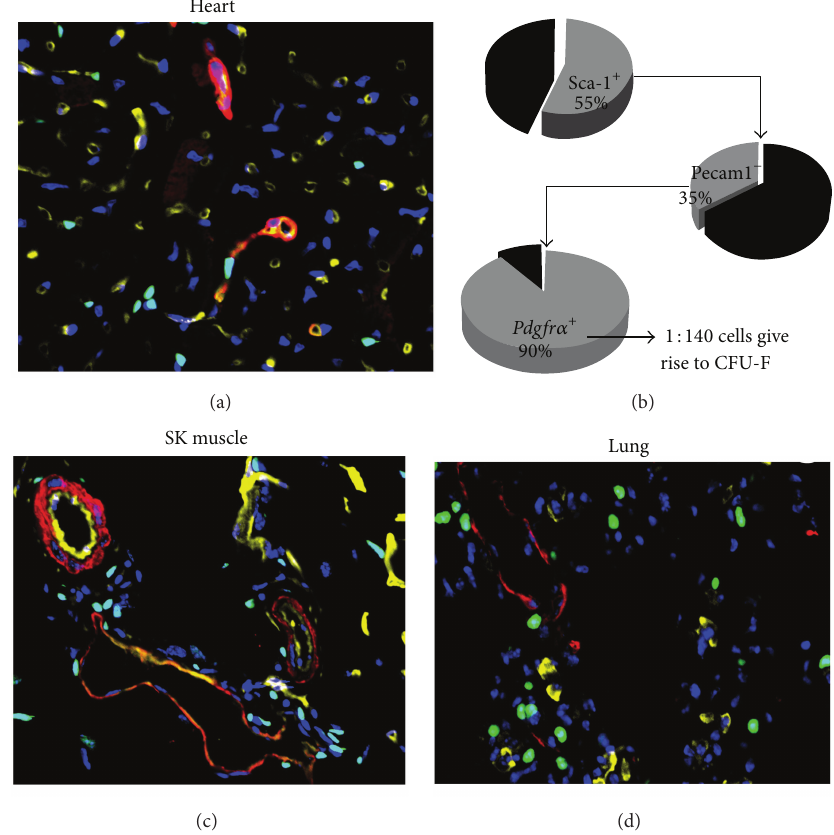
Figure 1: (a) Immunohistochemistry staining of smooth muscle alpha actin (red) and bandeiraea simplicifolia lectin (yellow) on tissues collected from Pdgfr 𝛼 -GFP mouse (B6.129S4-Pdgfr 𝛼 tm11 ( EGFP ) Sor / J ). The green fluorescence represents the Pdgfr 𝛼 positive cells. The image shows a broad expression of the cells in the heart (a) and CFU-F enrichment strategy for the cardiac SCA- 1 + Pdgfr 𝛼 -GFP + cells (b). Similar localization Pdgfr 𝛼 -GFP is seen in skeletal muscle and lung interstitium (c,